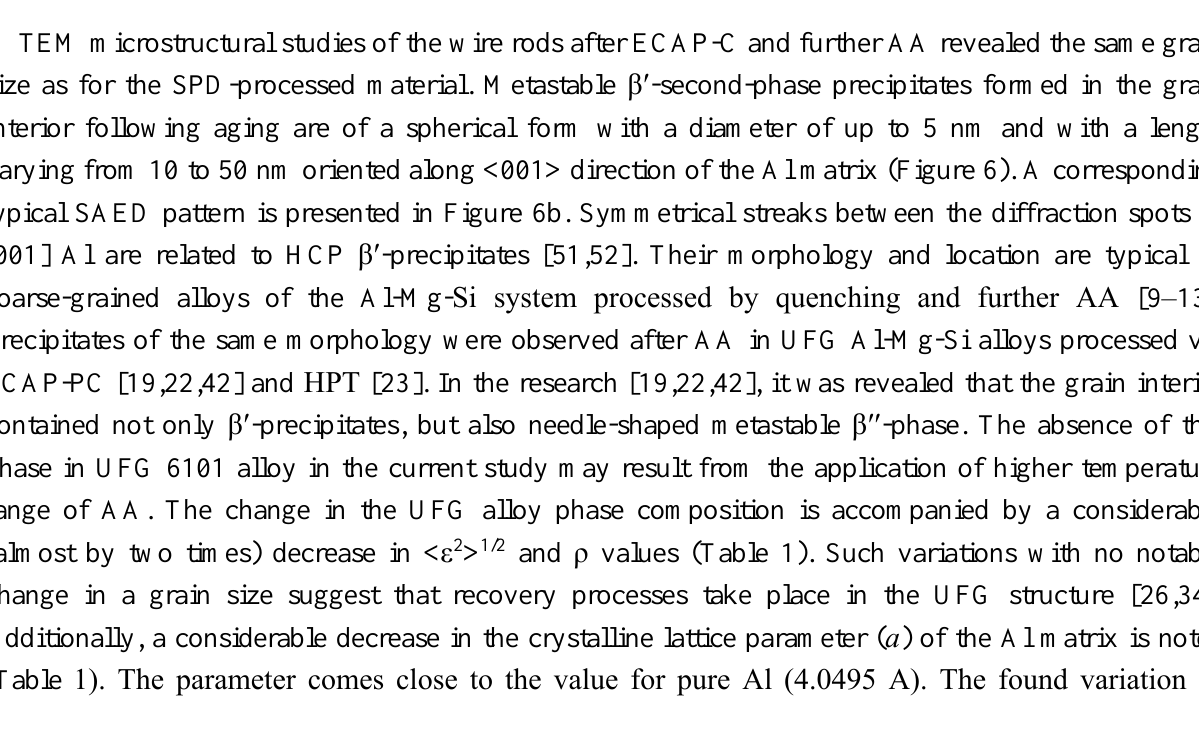
Figure 5. Change in electrical conductivity of test samples of the Al 6101 rod wire after ECAP-C and AA over